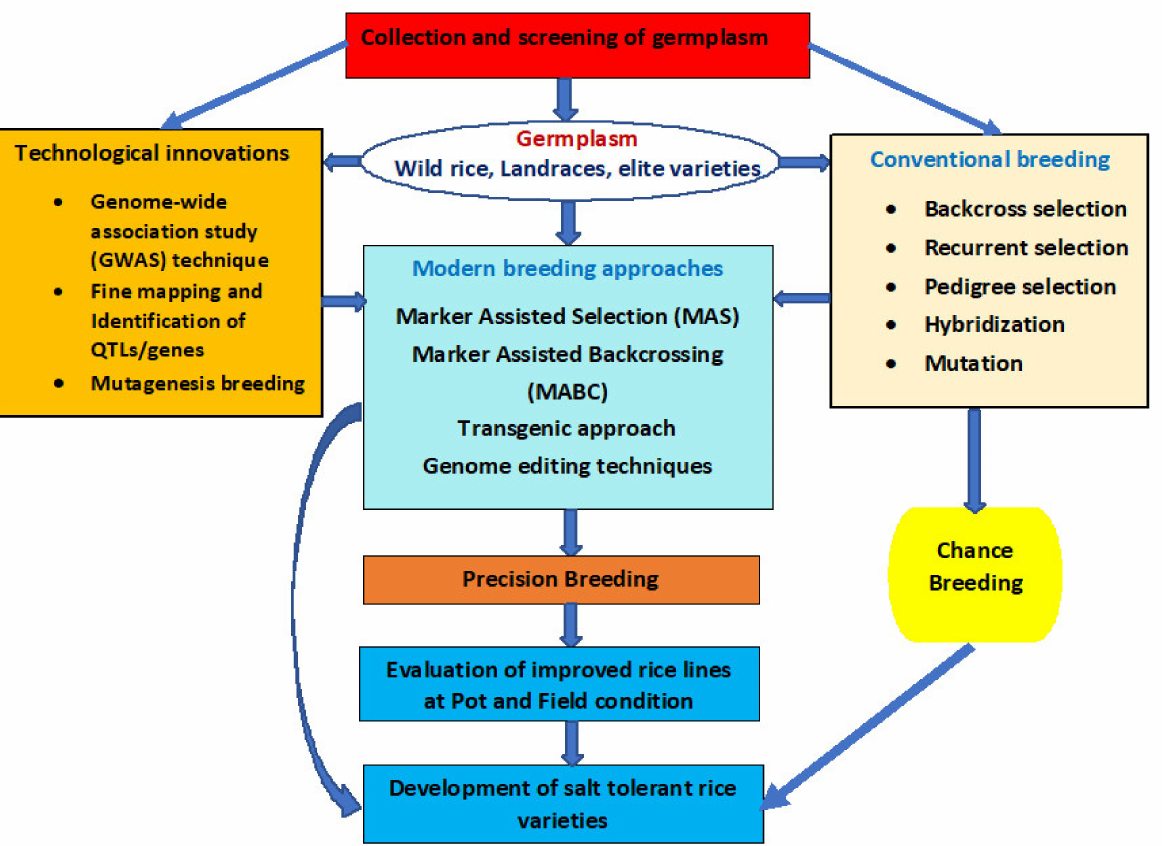
Figure 2. The integration of different breeding tools for developing salt-resilient rice